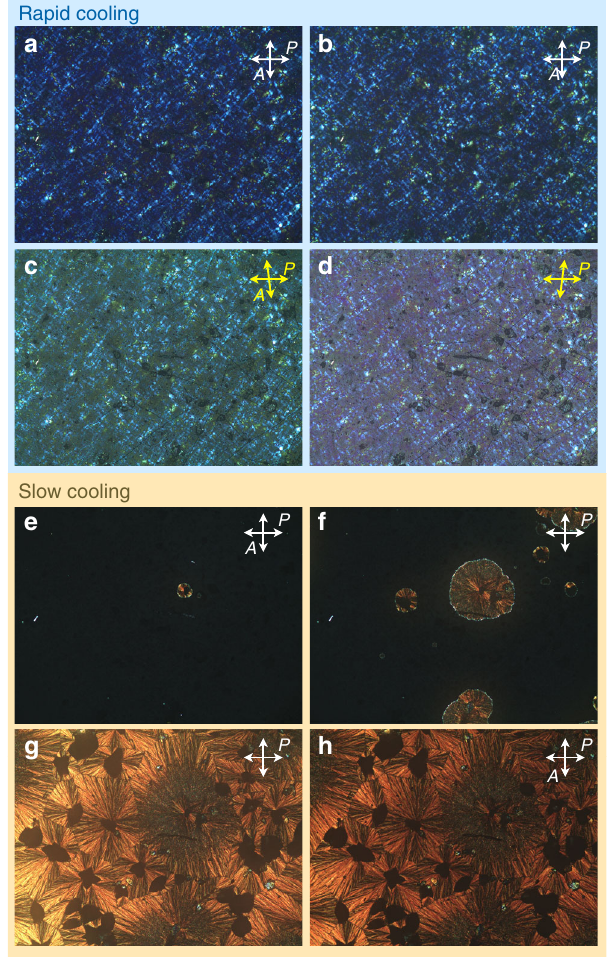
Fig. 3 Polarized optical microscopy. Polarized optical photomicrographs of compound 1 after heating to the isotropic liquid phase ( > 153 °C). On heating, no LC phase or phase transition is detected: a – d upon rapid cooling (rate > 50 °C min − 1 ) from the isotropic liquid phase the textures between crossed polarizers are shown in: a at 130 °C and b at 30 °C. c , d show the textures at 110 °C under decrossed polarizers. e – h Textures seen upon slow cooling at 2 °C min − 1 : e at 146 °C, f at 144 °C, g at 142 °C, and h at 30 °C. See Supplementary Information (Supplementary Note 5, Supplementary Figure 13) for higher magni fi cation/resolution